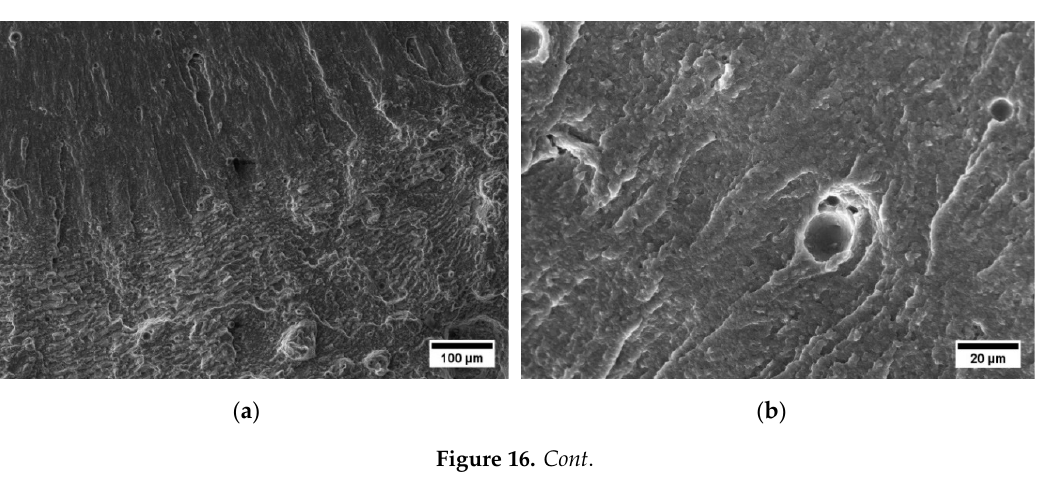
Figure 15. Fracture surfaces of the MP samples: ( a , b ) failed at the maximum stress of 215 MPa; ( c , d ) failed at the maximum stress of 195 MPa.